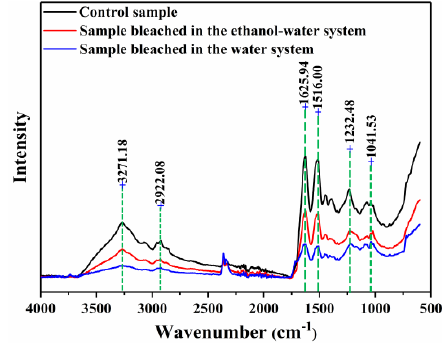
Figure 7. FTIR spectra of camel hair before and after bleaching treatment.